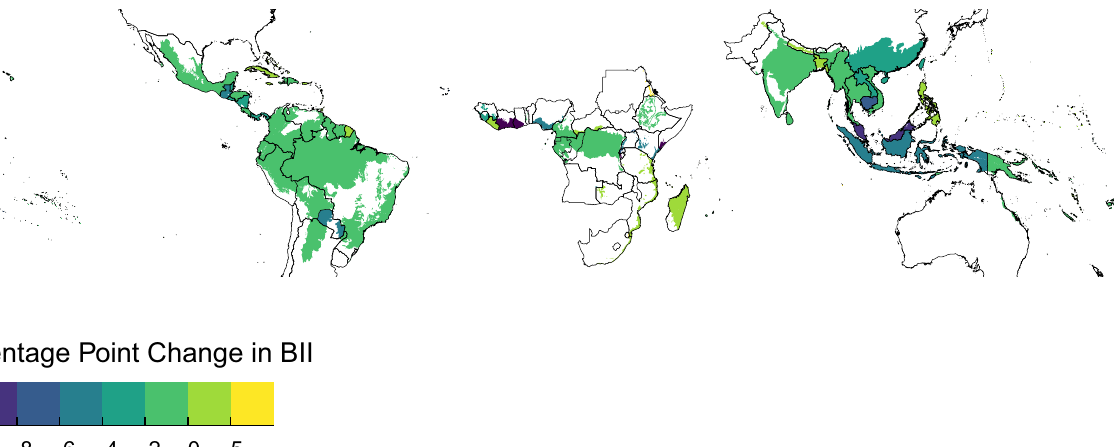
Figure 1. Map of country level differences in BII between 2001 and 2012 (expressed as percentage point difference). Increases in BII can occur if the abundance of originally-present species increases, so there is no upper limit to BII values and therefore to possible percentage point increase. BII cannot be less than zero, therefore the maximum possible decrease in BII is − 95 percentage points (as the highest country-level mean value of BII in 2001 was